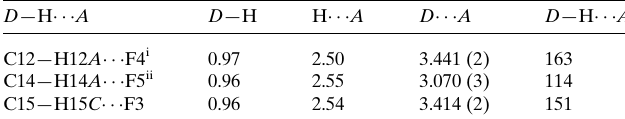
Table 1 Hydrogen-bond geometry (A˚ , (cid:4) ).